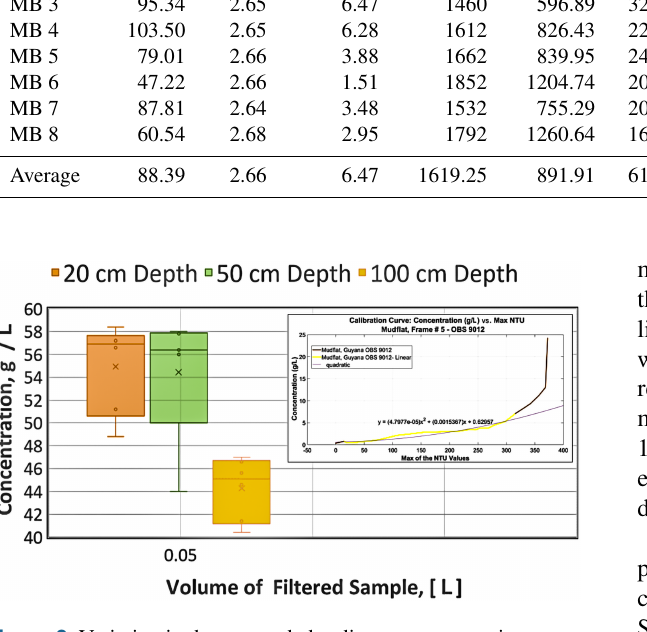
Figure 8. Variation in the suspended sediment concentration across the water depth at 20, 50 and 100cm above the bed level with com- parison to calibration concentrations observed in the